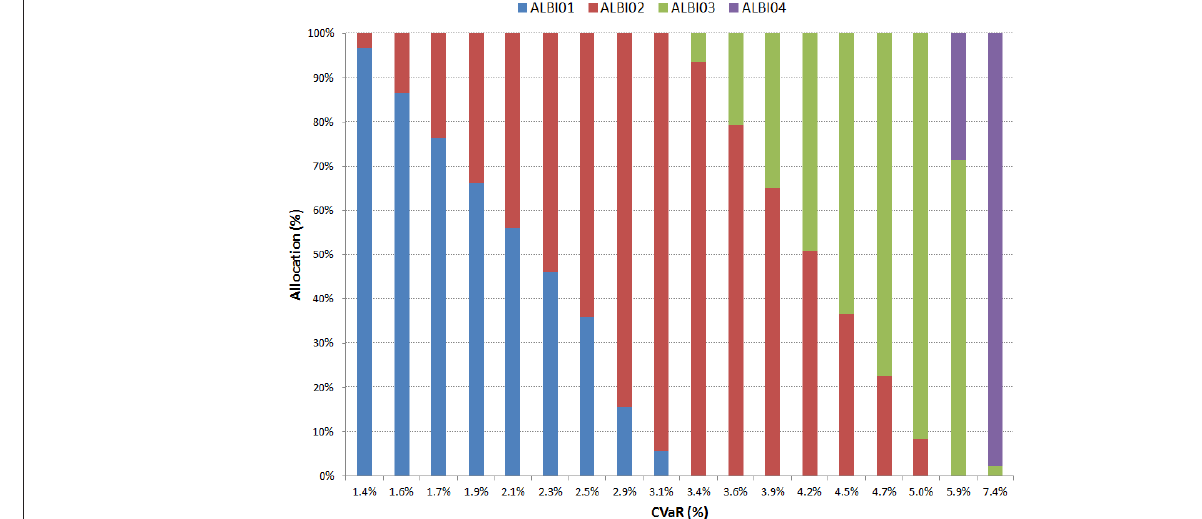
Figure 2: Efficient frontier allocation.